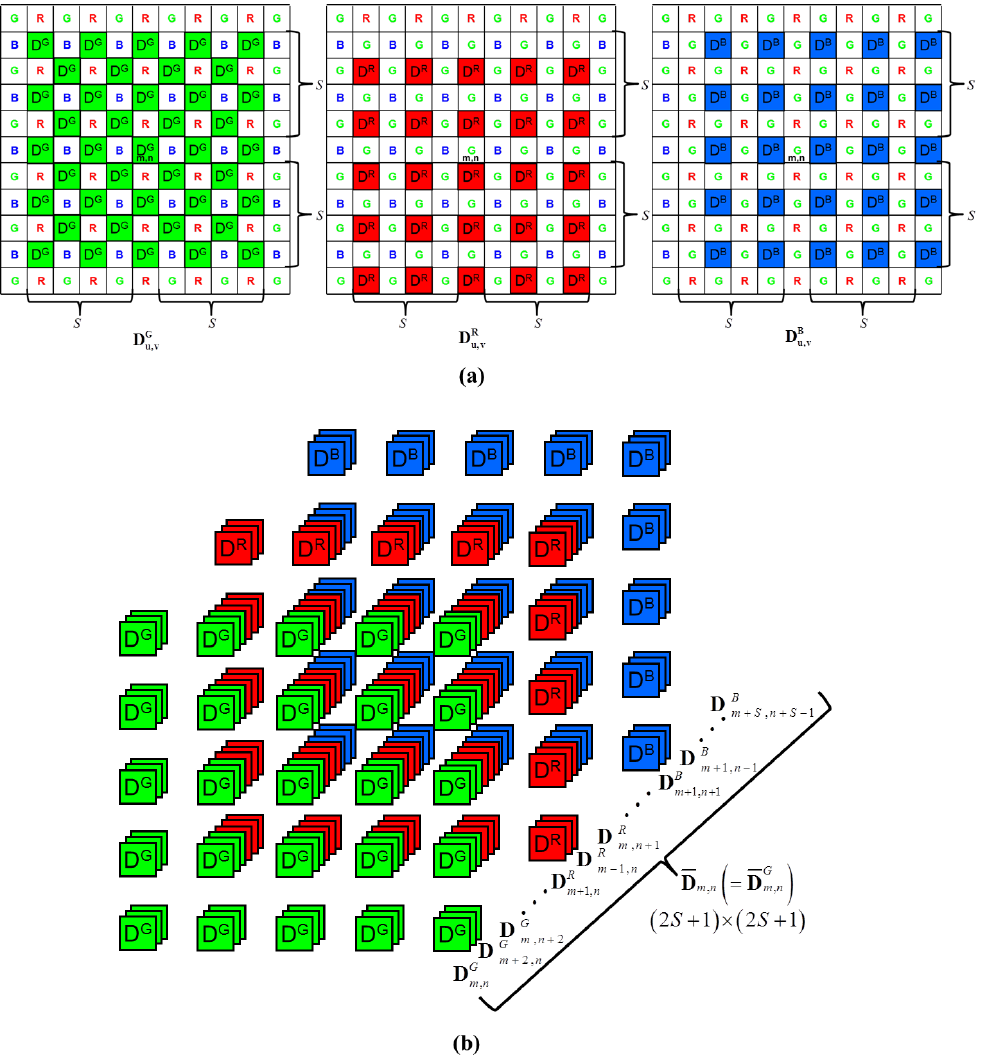
Figure 5. Schematic representation of the inter-channel correlated PBD refinement procedure. ( a ) the PBD image calculation procedure; ( b ) the PBD images stacking and refinement procedure.